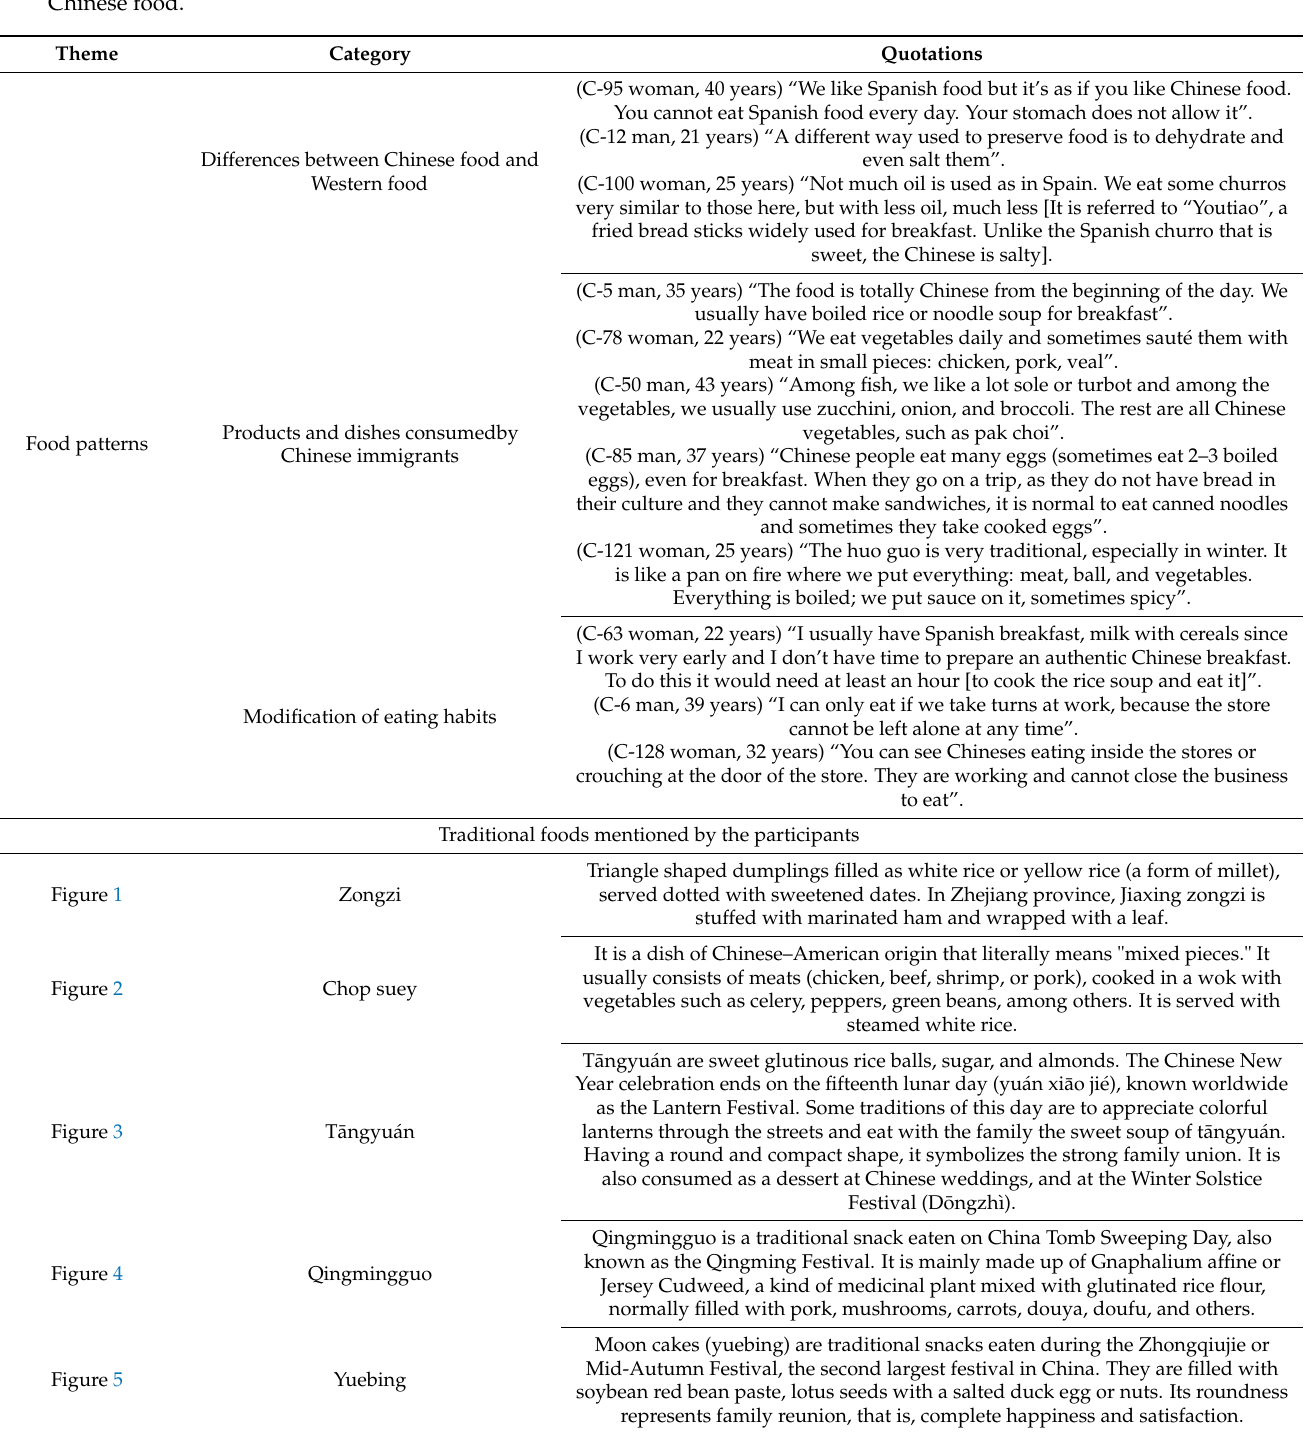
Table 2. Emergent categories and distribution of verbatim quotations on food patterns and descriptions of traditional Chinese food.